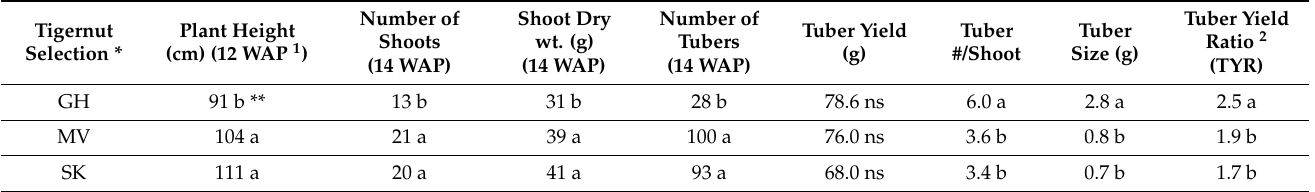
Table 4. Growth characteristics of GH, MV, and SK selections of tigernut in 20-cm diameter pots in the hoop house. The study was terminated 14 WAP when vegetative growth had stopped.